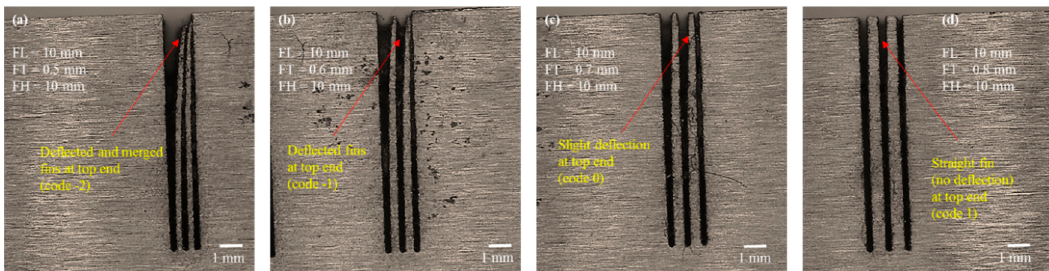
Figure 12. Microscopic analysis of structure traits in the third phase of experimentation, with FL 10 mm and FH 10 mm: ( a ) FT_d 0.5 mm, ( b ) FT_d 0.6 mm, ( c ) FT_d 0.7 mm, ( d ) FT_d 0.8 mm.